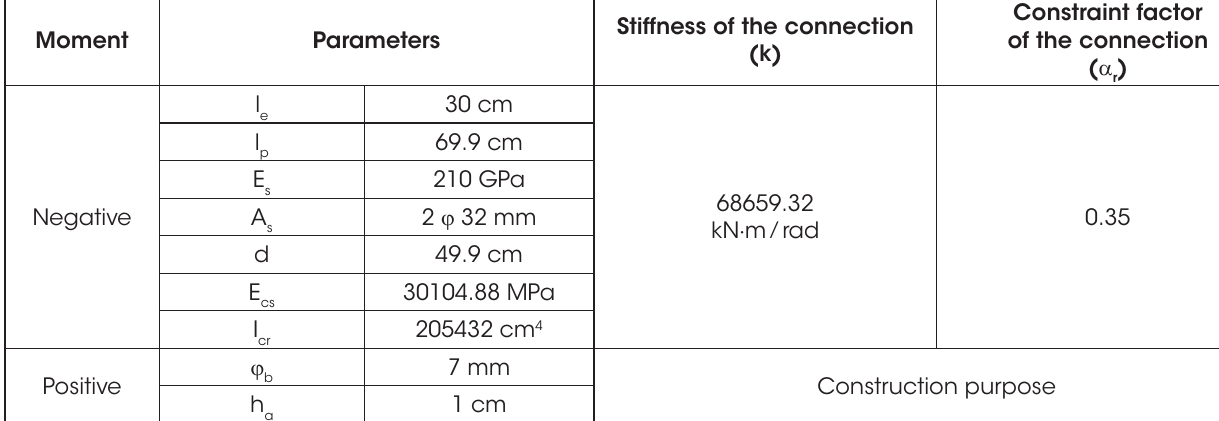
Table 5 Connection for the central column Moment